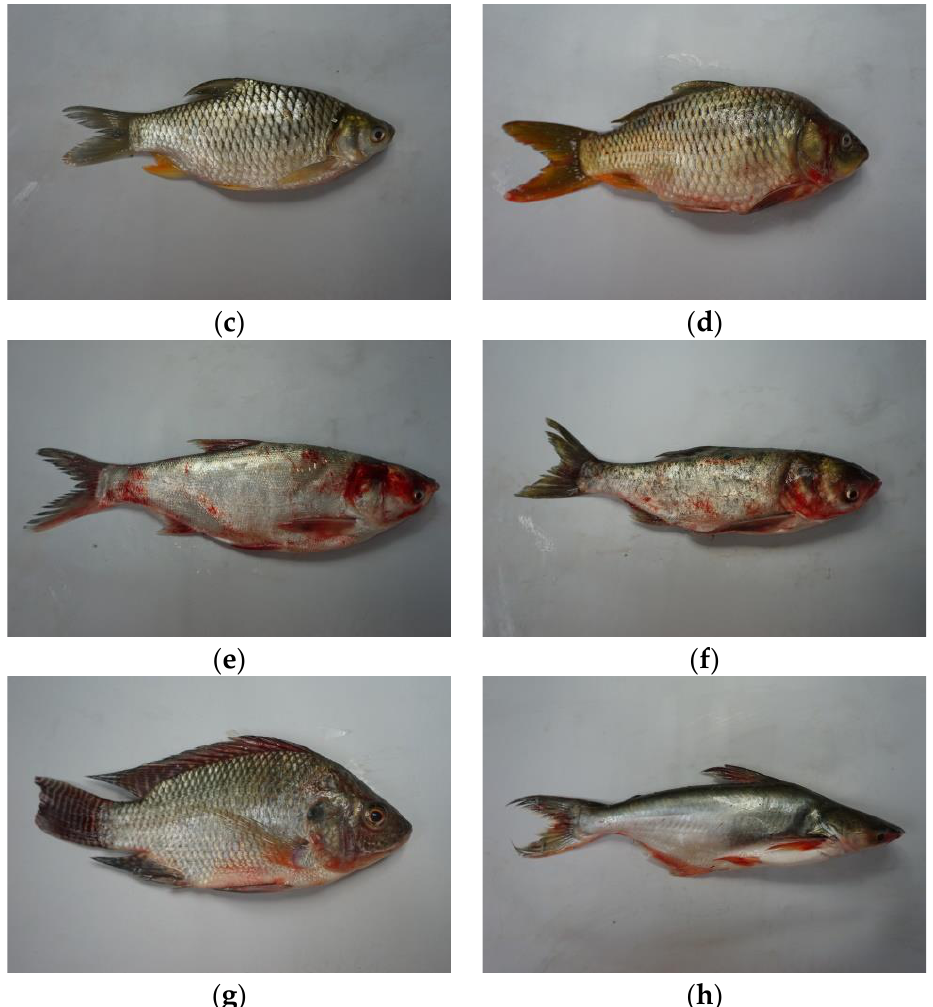
Figure 1. Sample picture of fish: ( a ) Yeesok; ( b ) Nuanchan; ( c ) Tapian; ( d ) Nai; ( e ) Jeen Ban; ( f ) Jeen To; ( g ) Nin; and ( h ) Sawai.